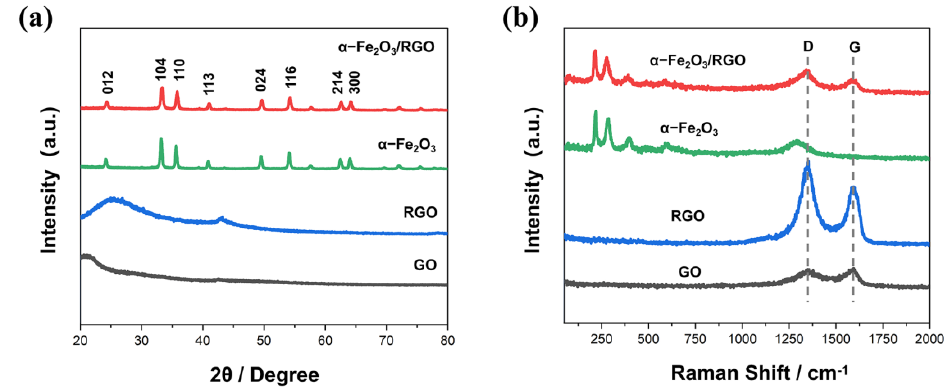
Figure 1. ( a ) XRD patterns and ( b ) Raman spectra of α -Fe 2 O 3 /RGO, α -Fe 2 O 3 , RGO, and GO. Figure 1b shows the Raman spectra of the α -Fe 2 O 3 /RGO, α -Fe 2 O 3 , RGO, and GO sam- ples. The D and G bands reveal typical peaks at 1350 cm − 1 and 1589 cm − 1 in all three gra- phene-related compounds. α -Fe 2 O 3 /RGO and RGO have higher I D /I G values than GO, in-